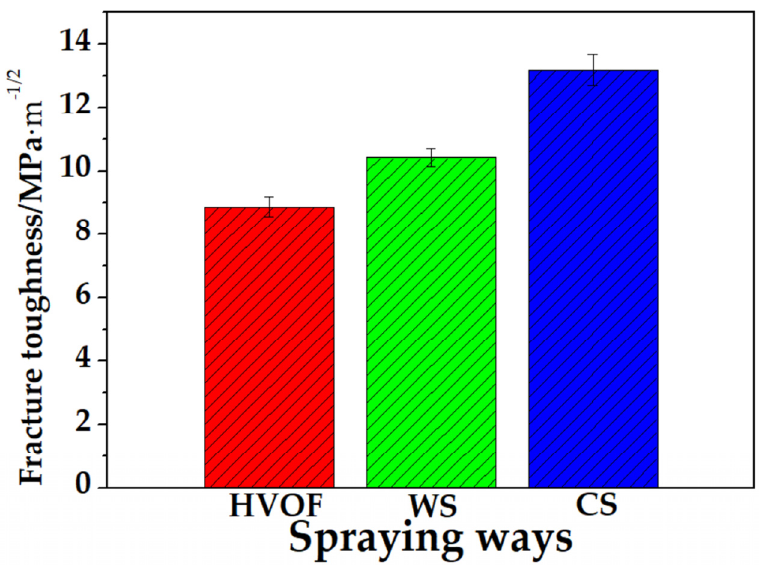
Figure 16. Fracture toughness of WC-17 coatings formed by various spraying methods.